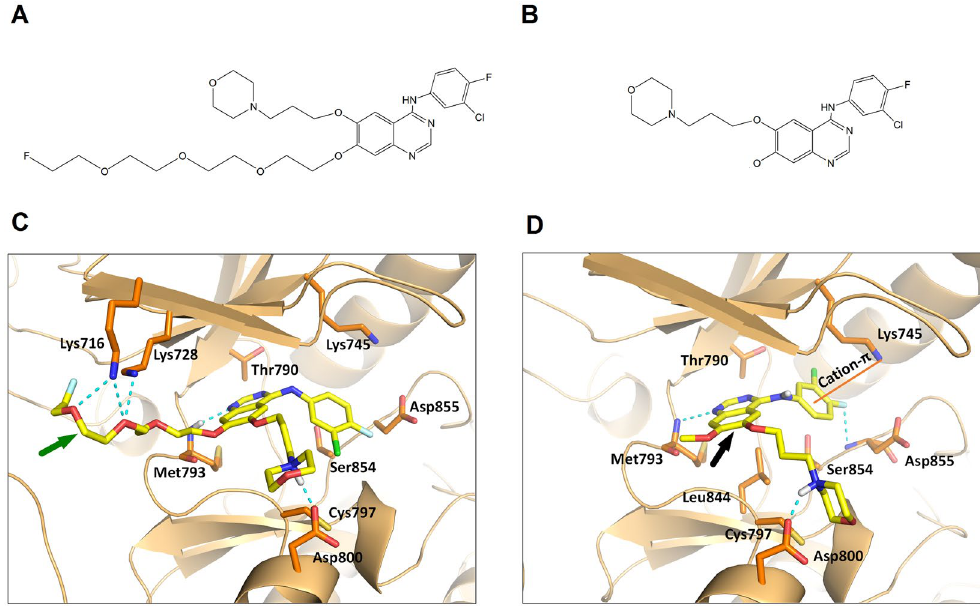
Figure 1. Chemical structures of F-IRS ( A ) and gefitinib ( B ). Predicted docking modes of F-IRS ( C ) and gefitinib ( D ) with EGFR 19 exon deleted structure. F-IRS (green arrow indicates F-IRS structure) binds to the receptor in a similar orientation as gefitinib (black arrow indicates gefitinib structure), maintaining interactions with Met793 and Asp800, and forming extra hydrogen bonds with Lys 745, Lys716 located in the intracellular domain of EGFR 19 exon deleted